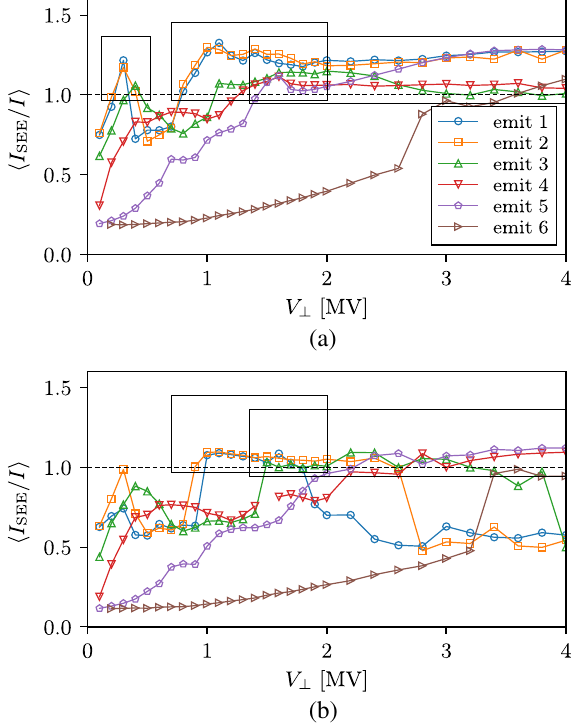
FIG. 16. Electron growth rate versus impact energy for different emitter locations using the secondary electron yield of Nb, (a) after 300 °C baking, and (b) after a surface treatment with argon. The three multipacting barriers are highlighted. The simulations are carried out using CST